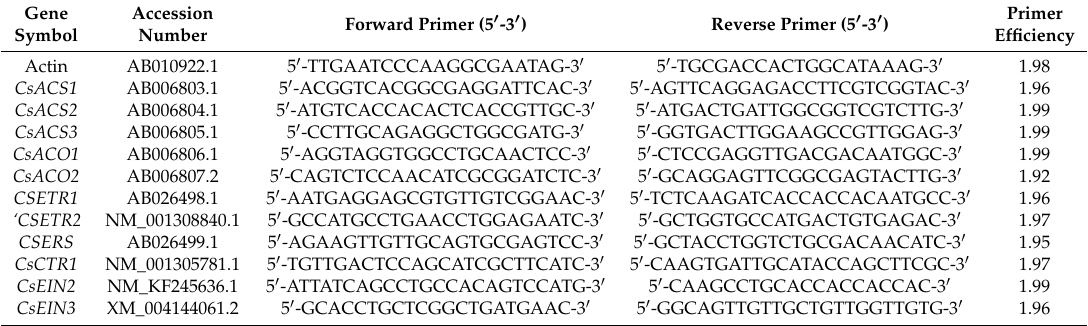
Table 1. Primers used for Quantitative Real-time PCR (qPT-PCR)